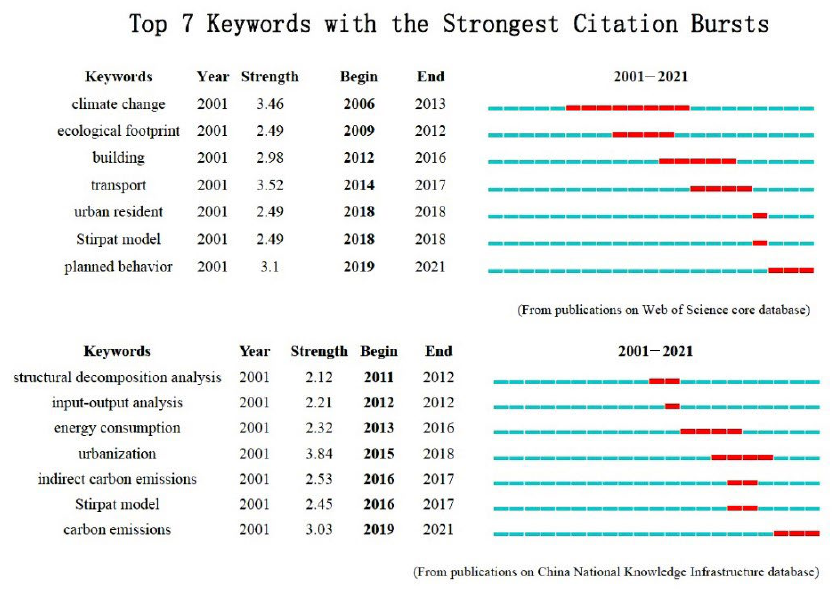
Figure 6. Clustering map of keywords of Web of Science publications.